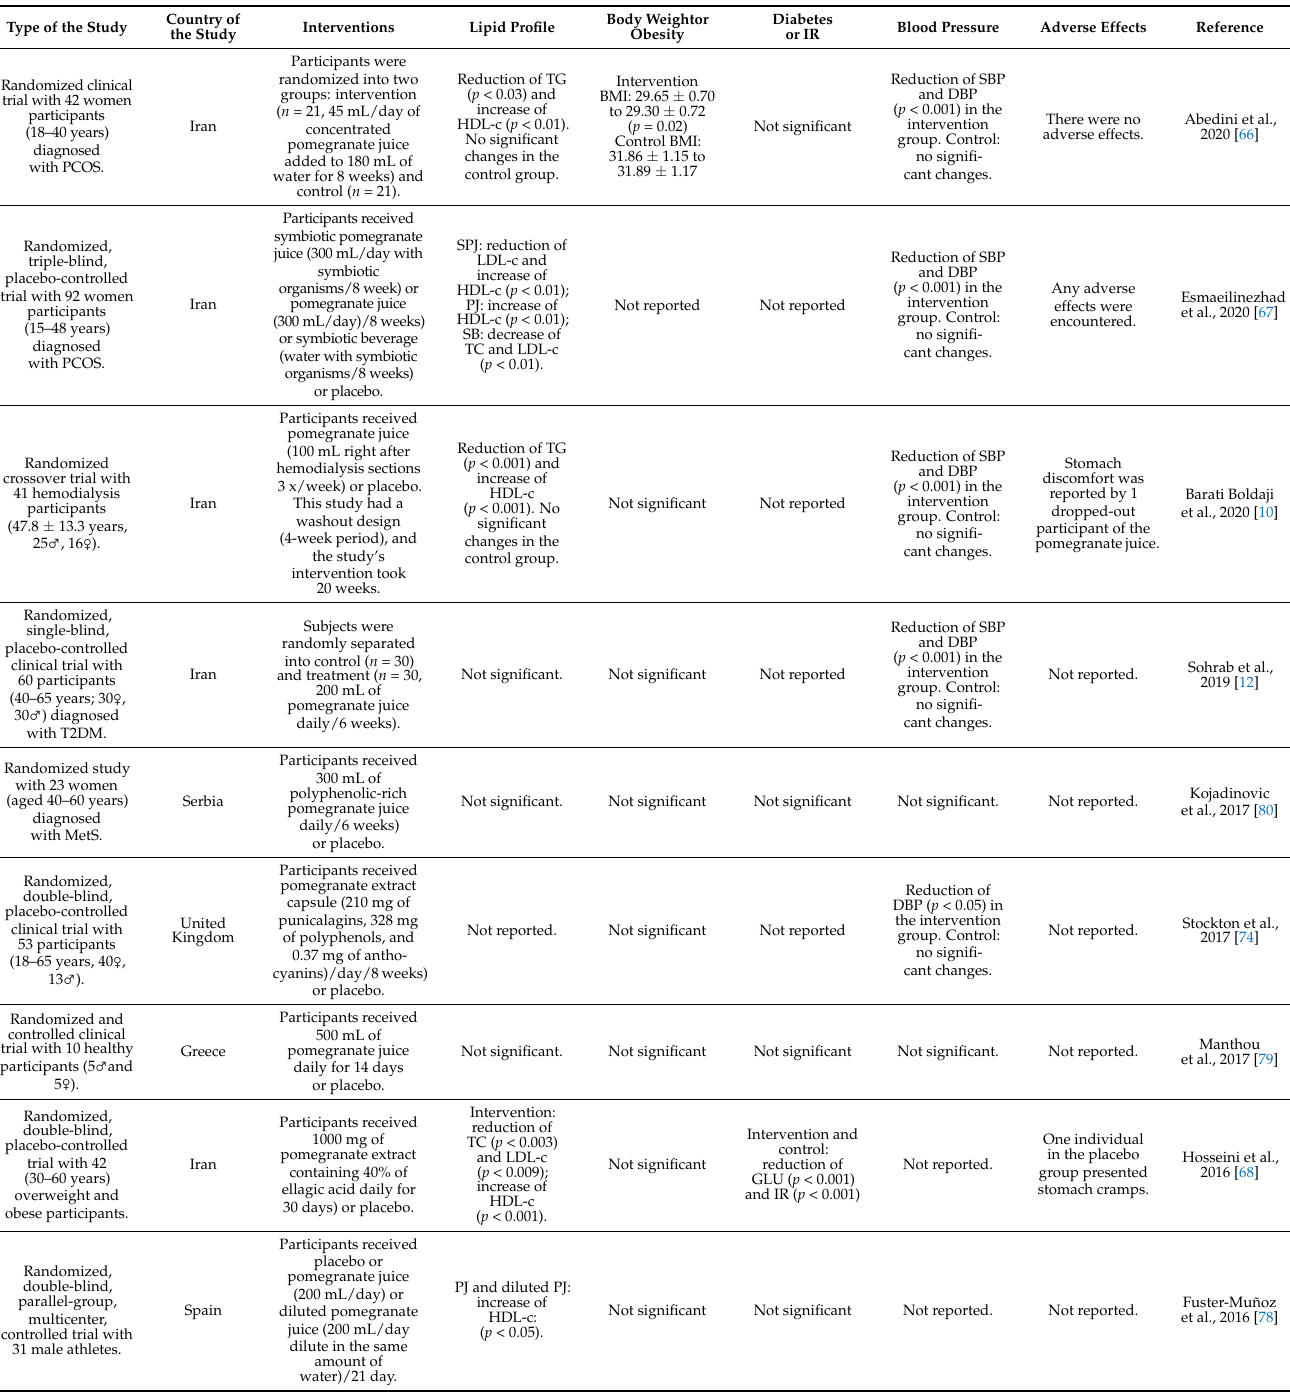
Table 2. The effects of P. granatum on various components of